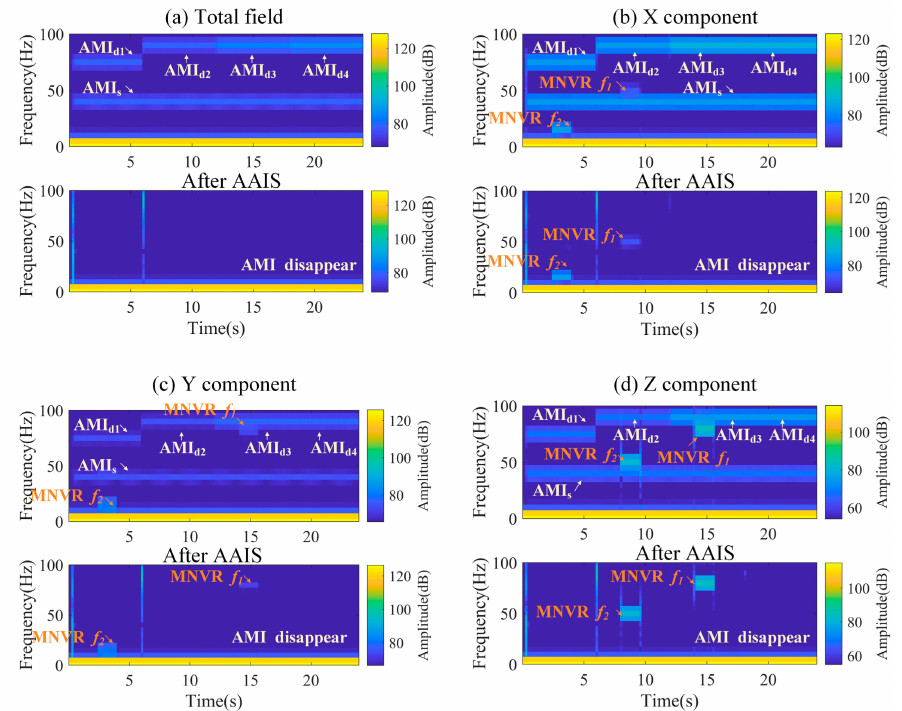
Figure 7. Time–frequency diagrams of the data before and after AAIS for the dynamic AMI. ( a ) Total magnetic field; ( b ) X component; ( c ) Y component; ( d ) Z component. AMI is the abbreviation for alternating magnetic interference. AMI s is the abbreviation for static AMI. AMI d is the abbreviation for dynamic AMI. MNVR is the abbreviation for